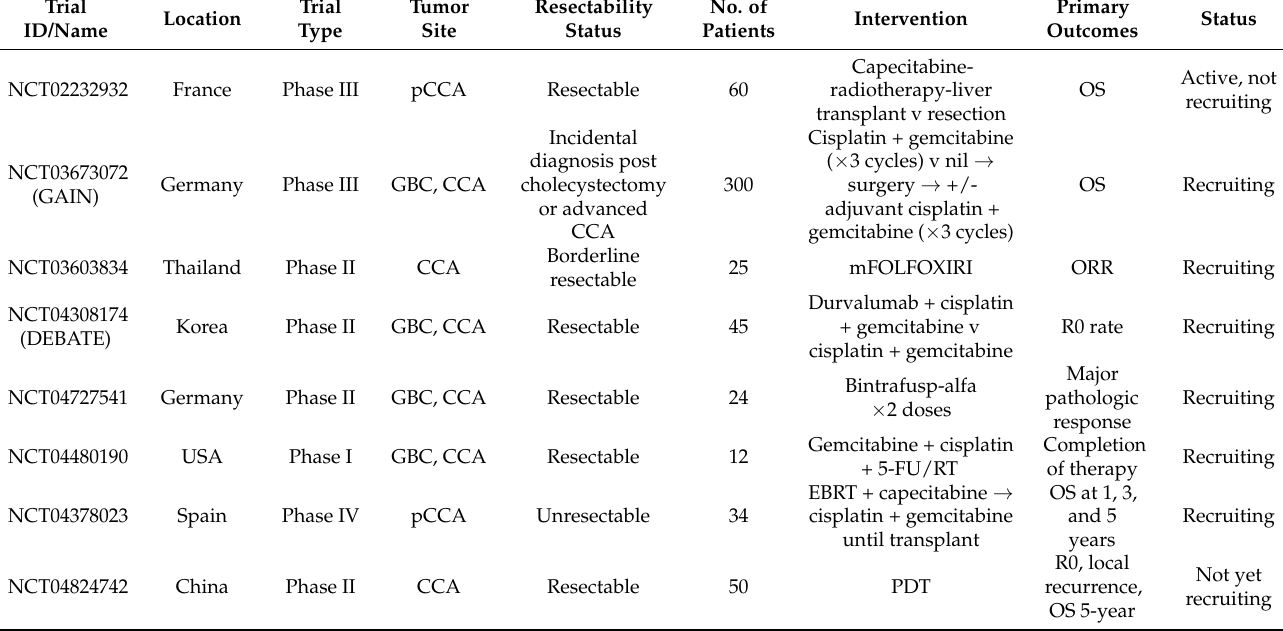
Table 1. Neoadjuvant trials including perihilar